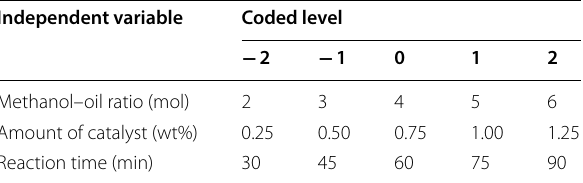
Table 1 Range and level of the variables based